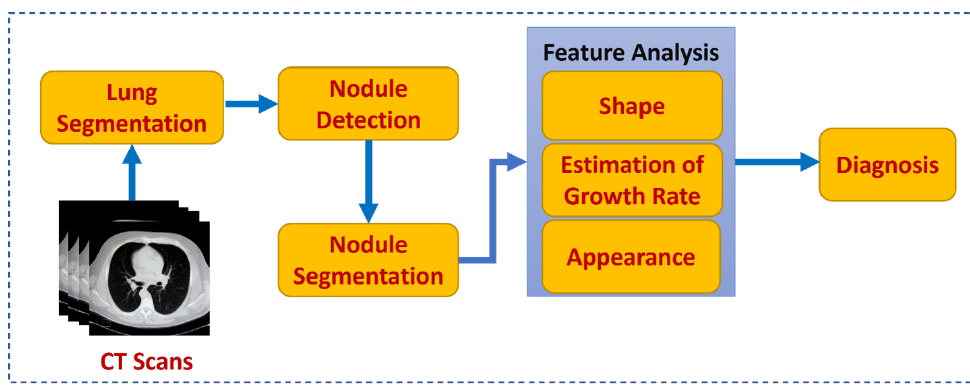
Figure 1. A Typical CAD System for Lung Cancer